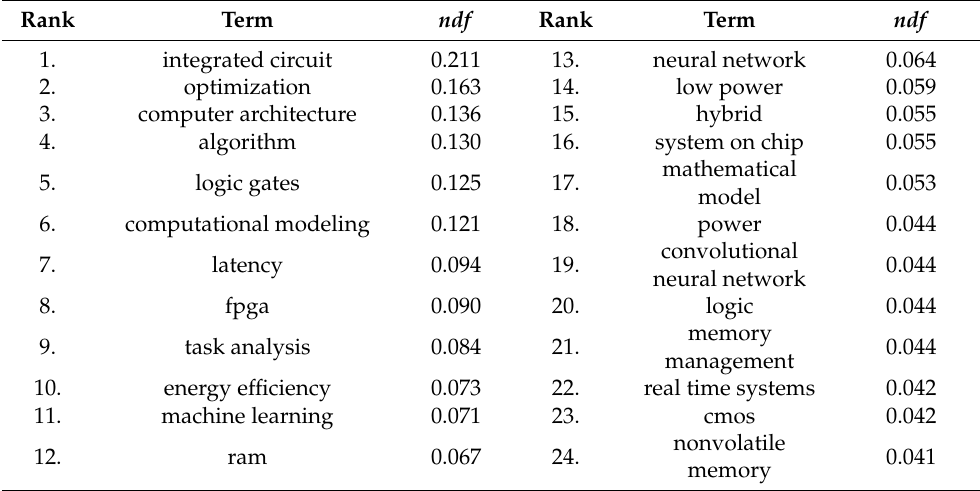
Table 1. Top 24 EDA terms in 2020 and their normalized document frequency